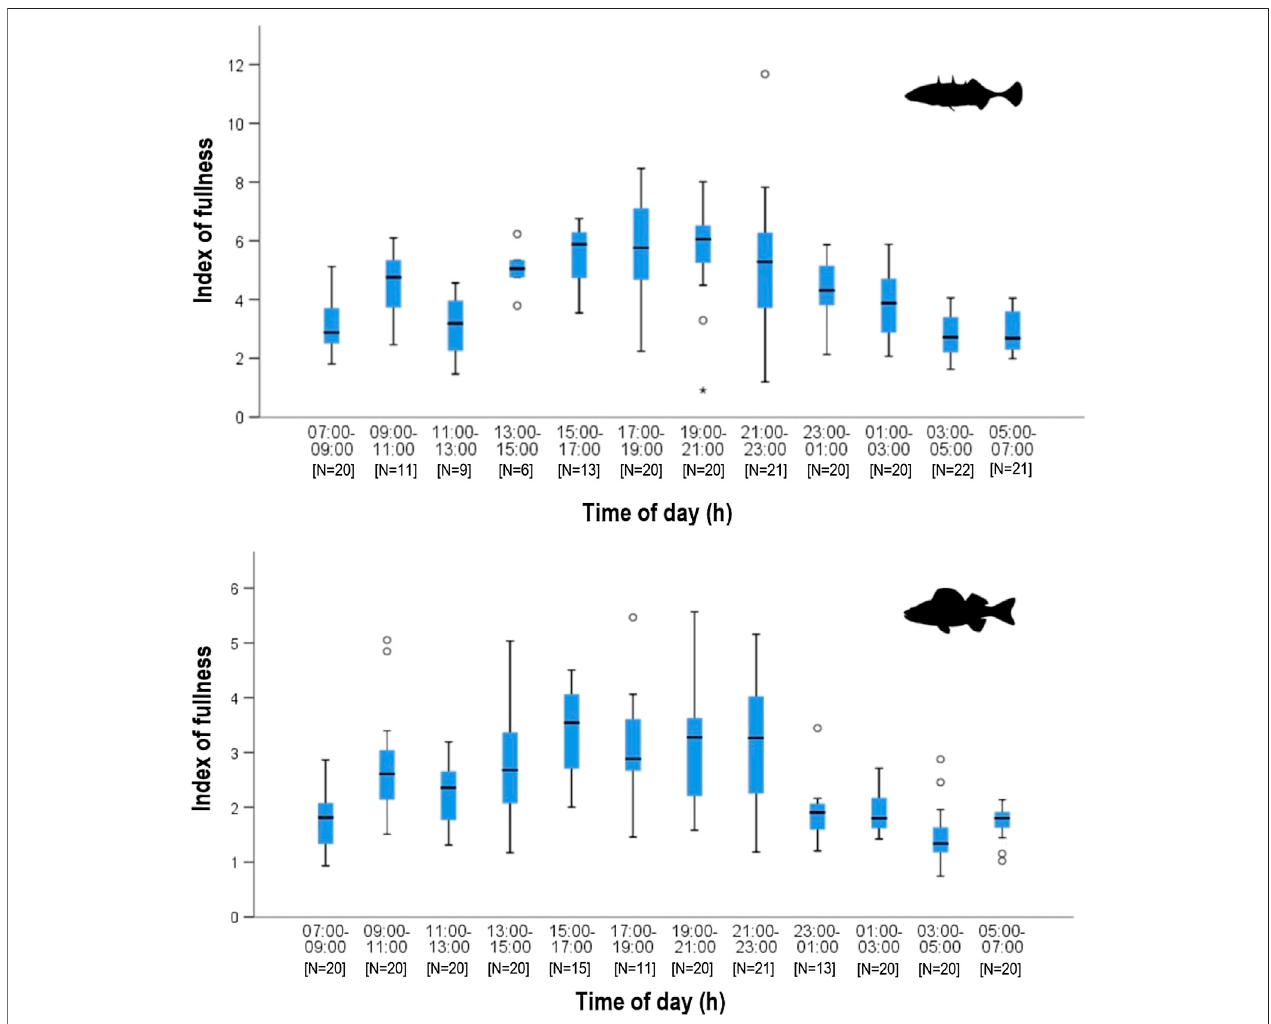
FIGURE4| Weight-basedstomachfullness(Hyslop1980)duringdaytimeinstickleback (top) andperch (bottom) fromLakeConstanceinautumn.Higherfullness index corresponds to fuller stomachs.